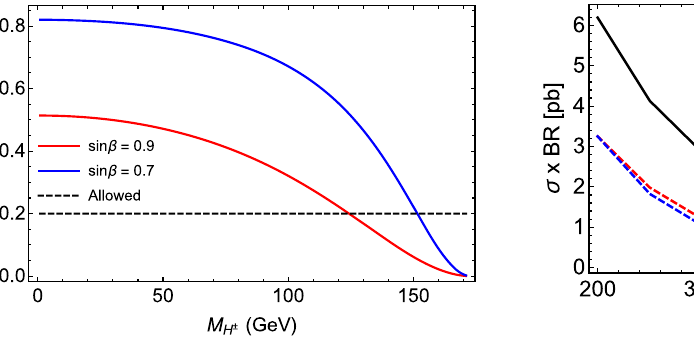
Fig. 12 The pseudoscalar Higgs decay branching ratios into various final states for different values of sin β fixing sin α = − 1 √ m W (cid:6) = 400 GeV